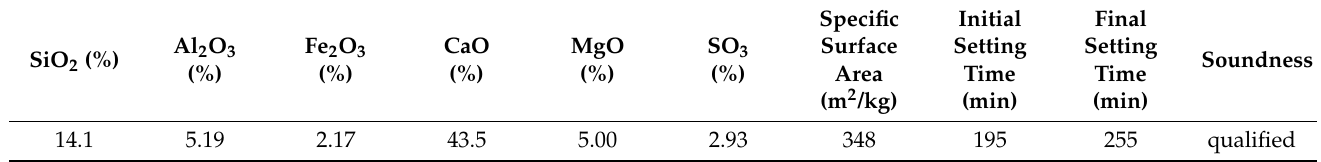
Table 1. Composition and physical properties of